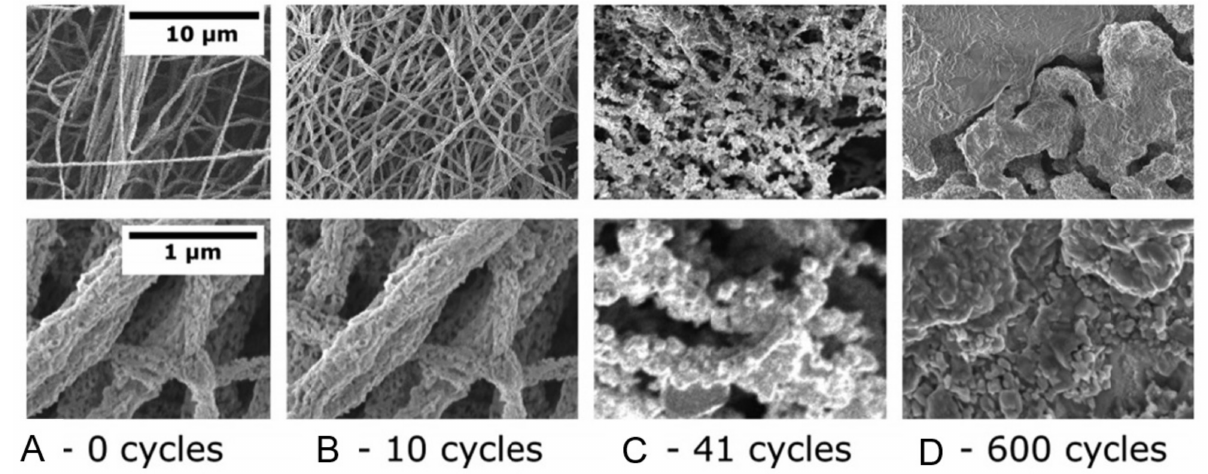
Figure 26. SEM images of CuO nanofibers after different numbers of H 2 S (10 ppm) sensing cycles (A → D). As-prepared CuO nanofibers had a diameter of 600–700 nm. Reprinted with permission from [341]. Copyright 2019 De